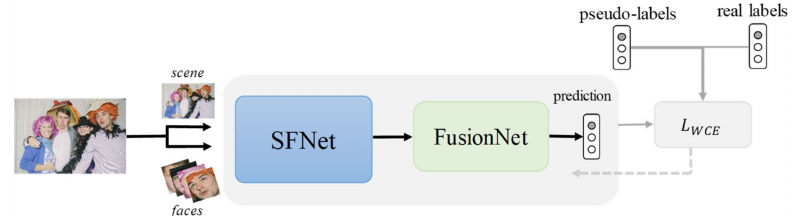
Figure 4. Further Training of